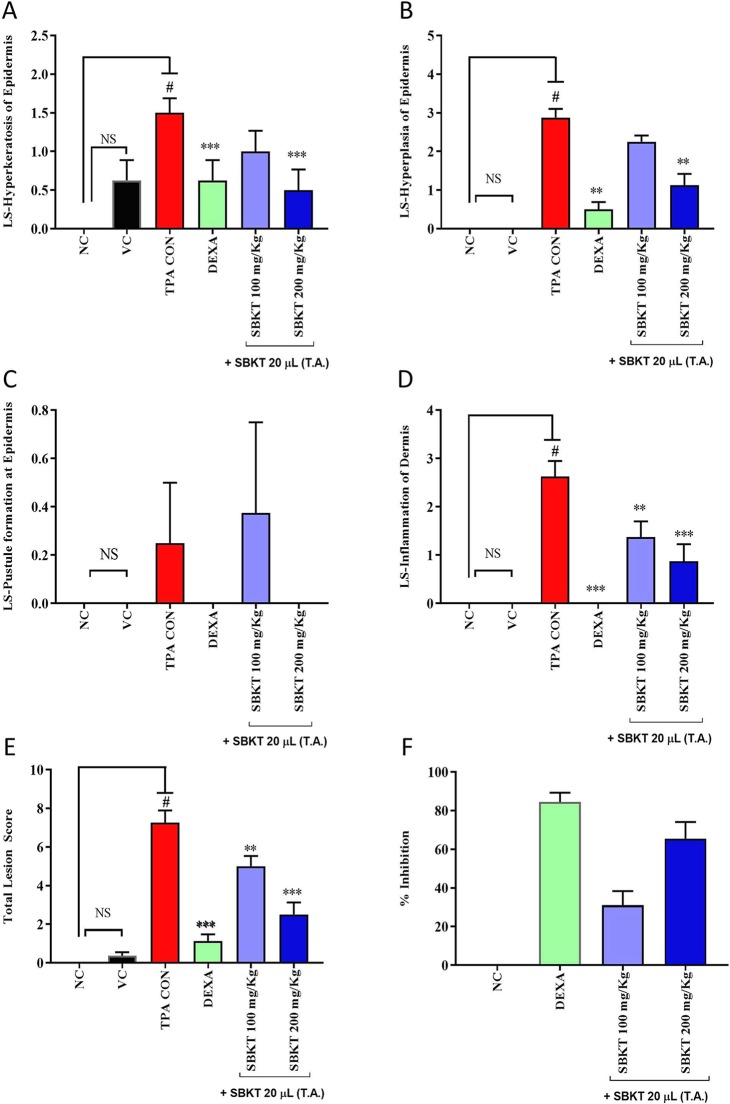
Effect of SBKT on TPA-induced inflammatory lesions in mice ear. Mice co-treated with TPA and DEXA or SBKT showed a reduction in histopathological lesions viz. (A) Hyperkeratosis of the epidermis. The data clearly demonstrated the considerable decrease in hyperkeratosis score by SBKT at 100 and 200 mg/kg (p < 0.001) in comparison to TPA CON. (B) Hyperplasia of the epidermis. Results showed a decrease in hyperplasia score by SBKT at 100 and 200 mg/kg (p < 0.001). (C) Pustule formation at the epidermis. Only SBKT at 200 mg/kg (p < 0.001) was found to reduce pustule formation in comparison to TPA CON. (D) Inflammation of the dermis. A significant decrease in dermal inflammation score was observed following treatment with SBKT at 100 (p < 0.01) and 200 mg/kg (p < 0.001). (E) Results showed a significant decrease in total lesion score at 100 (p < 0.01) and 200 mg/kg (p < 0.001). Represents percentage inhibition of total lesion score. % Inhibition data have not been statistically compared between SBKT 100 and SBKT 200 with DEXA. This panel represents % inhibition (activity) of SBKT 100, SBKT 200, and DEXA individually. (F) Percentage inhibition of total lesion score. High activity in inhibiting inflammatory lesions was observed in the SBKT at 200 mg/kg followed by 100 mg/kg in comparison to TPA CON. Statistical analysis was performed using one-way ANOVA followed by Dunnett’s multiple comparisons t test (n = 8 animals). #p < 0.001 (NC versus TPA CON), NS p > 0.05 (NC versus VC), **p < 0.01, ***p < 0.001 (TPA CON versus SBKT; TPA CON versus DEXA). NC, normal control; VC, vehicle control; TPA CON, TPA control; SBKT, sea buckthorn oil; DEXA, dexamethasone.